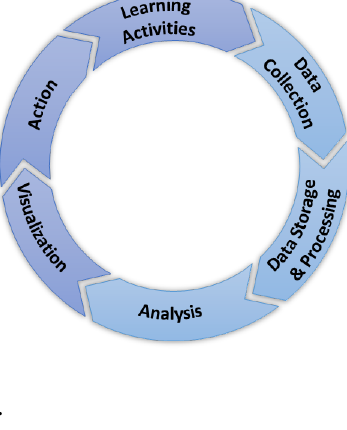
Figure 1. The learning analytics